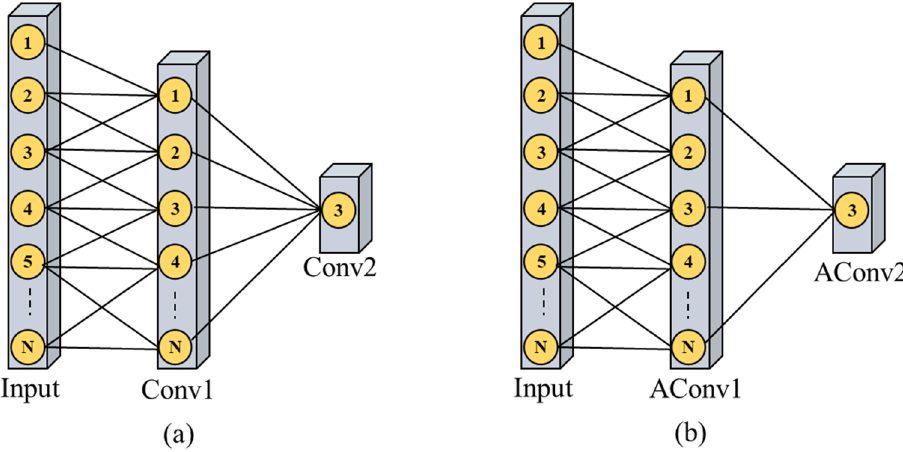
8 of 18 Figure 3. Original and refine data representation of the IHEPC dataset.